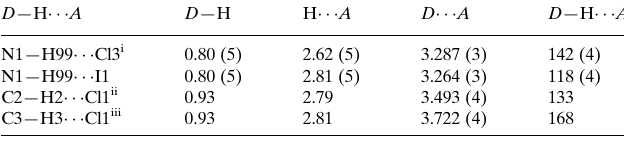
Hydrogen-bond geometry (A˚ , (cid:4)